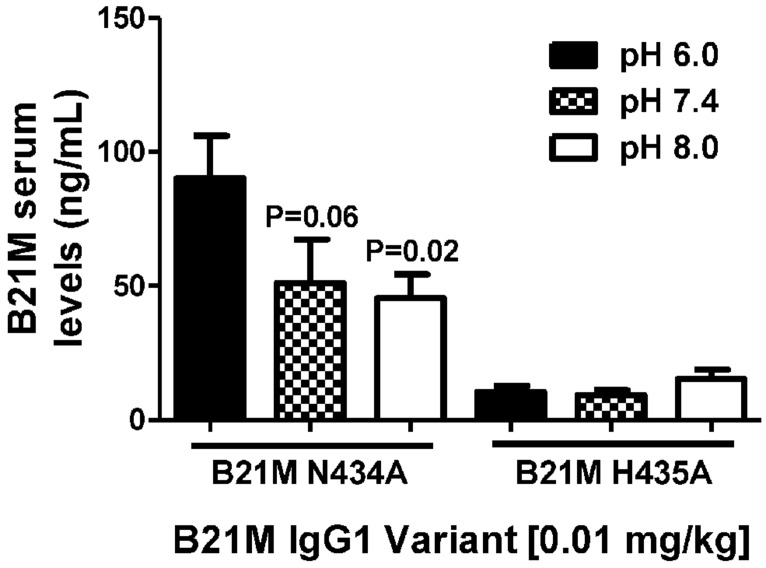
The effect of pH (pH 6.0, 7.4, and 8.0.) of high and low FcRn-affinity IgG variants on serum uptake: Serum levels (ng/mL) at 90 min after administration of N434A tended to be higher following intra-duodenal administration (0.01 mg/kg) in suckling rat pups (n = 6). There was no difference in the serum levels of H435A administered in different pH conditions. One-way ANOVA Statistical tests carried out compared to N434A pH 6.0.